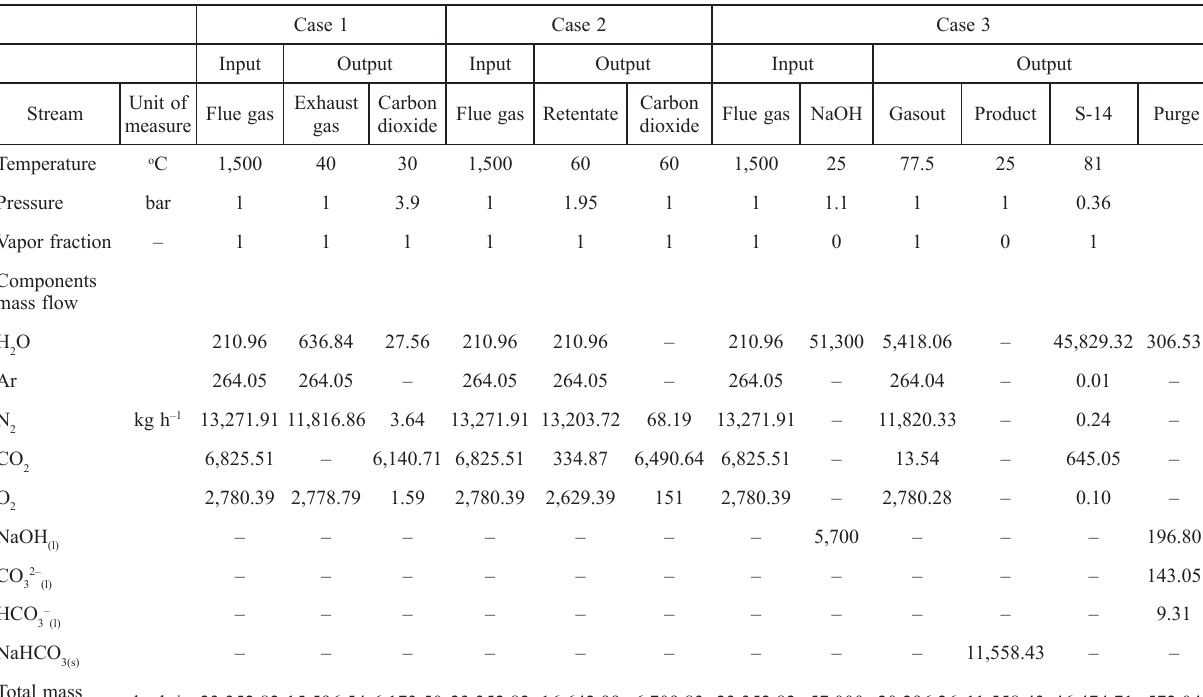
capture plants using MDEA (Case 1), membranes (Case 2), and NaOH (Case Table 6 – Material balance of the CO 2